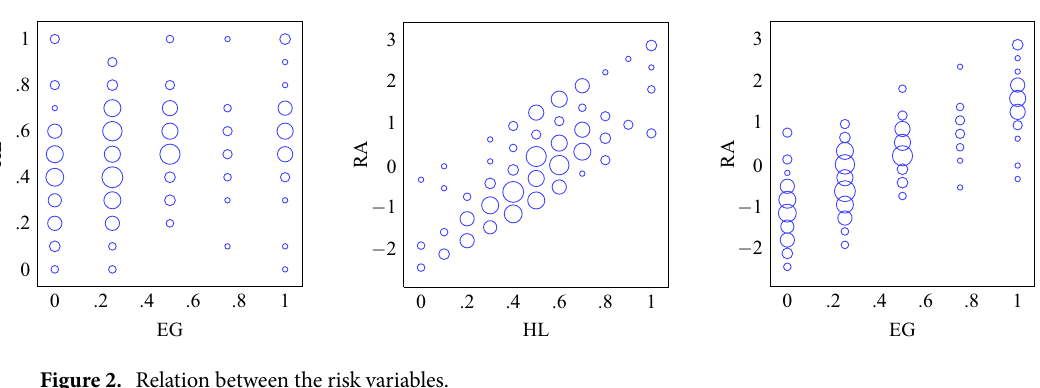
Figure 2. Relation between the risk